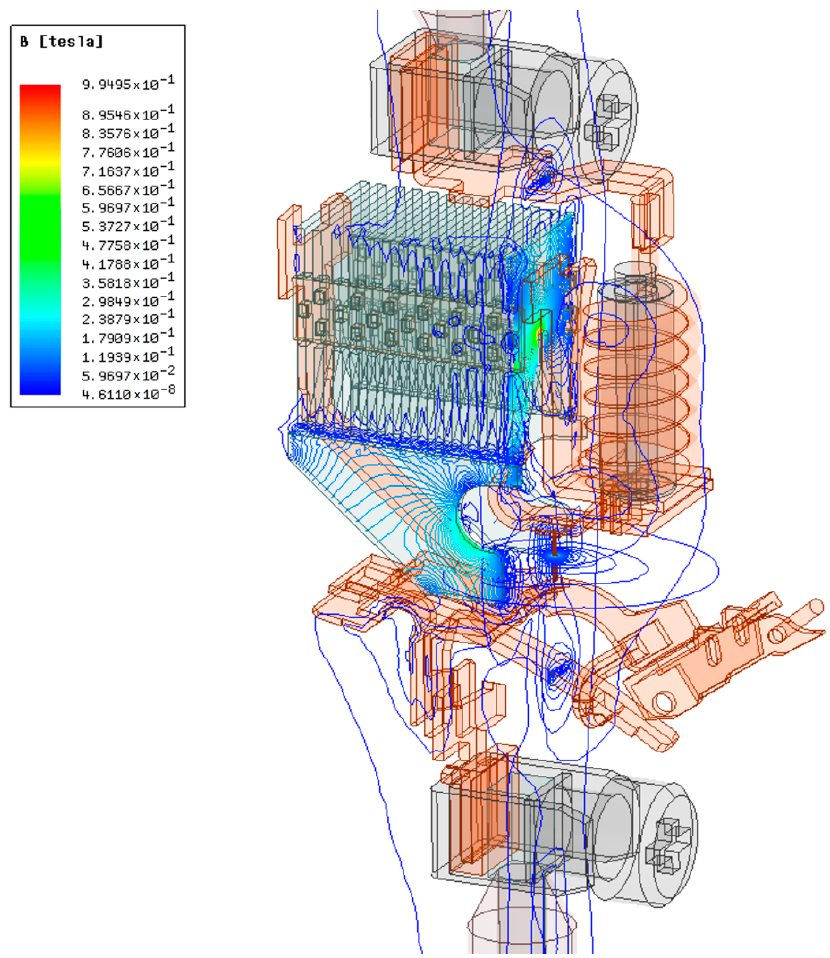
Figure 10. The distribution of electromagnetic induction density in the side ferromagnetic plates and in the plates of the extinguishing chamber at the moment of opening the contacts and the appearance of an electric arc.